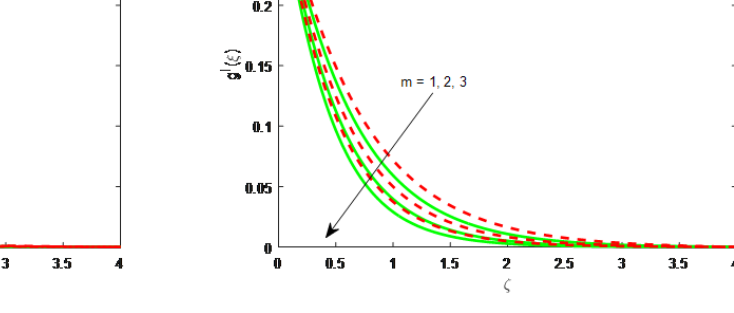
Fig. 18: Impression of Φ on g (cid:48) ( ξ )